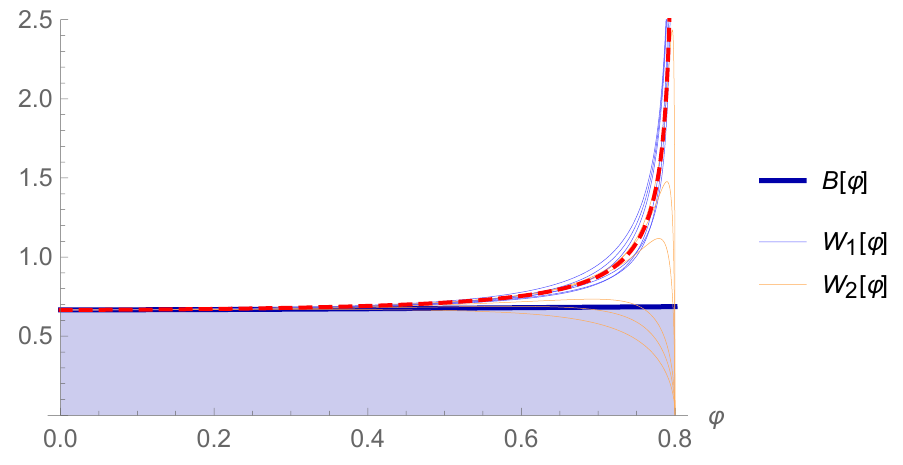
Figure 12 . Solutions W 1 ( ’ ) and W 2 ( ’ ) for the potential (8.1) with (cid:1) (cid:0) = 1 : 2 in the case where the sphere 1 shrinks. The six solutions di(cid:11)er in the value of T 2 ; 0 whereas ’ 0 = 0 : 8 is (cid:12)xed. From the lowest curve for W 2 to the highest one, T 2 ; 0 ‘ 2 increases, taking successively the values: 0 : 9 ; 4 : 5 ; 13 ; 5 ; 90 ; 270. The red dashed curve is the one towards which W 2 tends when T 2 ; 0 ‘ 2 ! + 1 on every interval in [0 ; ’ 0 [. The critical curve is de(cid:12)ned as B ( ’ ) (cid:17) S 4 [21], the superpotential W ( ’ ) cannot enter the area below the critical curve, which is depicted as the shaded region.